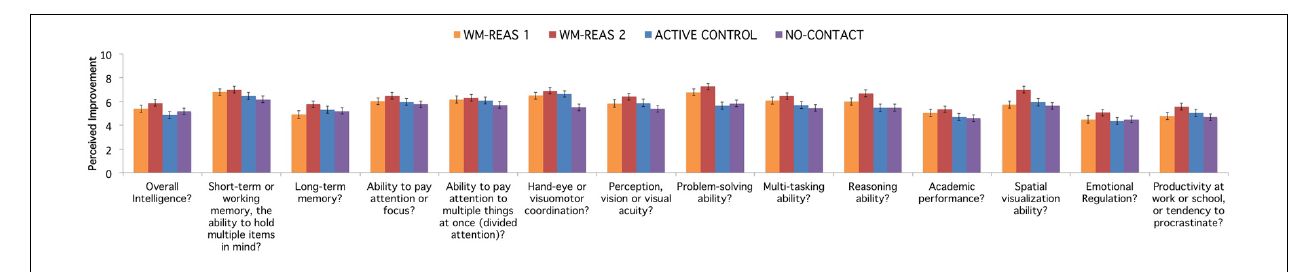
FIGURE 4 | Perceived improvement as a function of group. Average responses for each group, including data fromWM-REAS 1 and active control participants who did not receive a web-based version of the post-experiment survey. Error bars represent ±